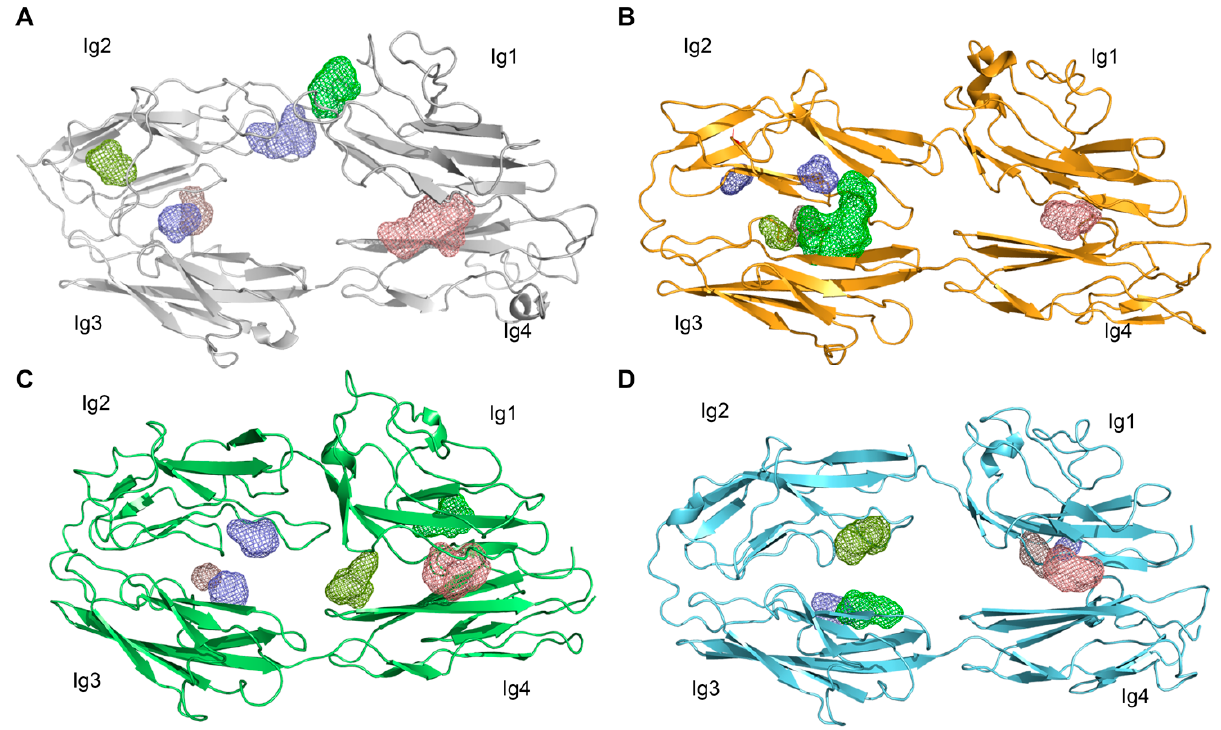
Figure 5. Prediction of putative peptide binding sites onto L1CAM horseshoe. ( A ) Wild type L1CAM, ( B ) L1CAM_R184A, ( C ) L1CAM_R184Q, ( D ) L1CAM_I179S. Each binding pocket is represented by a colored mesh.